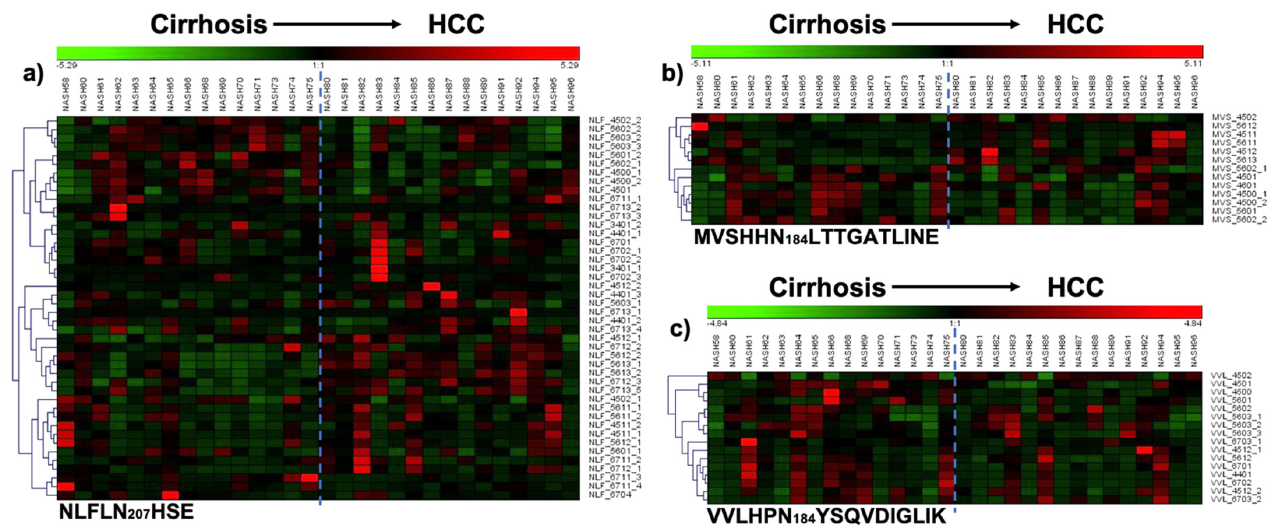
Figure 5. Heat maps for glycosylation site. ( a ) NLFLN207HSE (NFL + “Glycan”); ( b ) MVSHHN184LTTGATLINE (MVS + “Glycan”); and ( c ) VVLHPN241YSQVDIGLIK (VVL + “Glycan”). Glycan nomenclature: HexNAc, Hex, Fuc, NeuAc ( N -acetylhexosamine, hexose, fucose, N -acetylneuraminic acid, respectively). Color red (up-regulation) and color green (down-regulation).